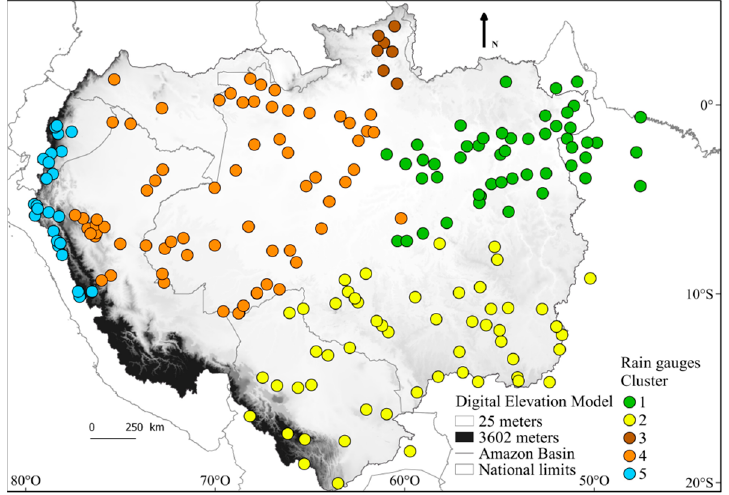
Figure 2. Rain gauge network used as ground reference (205 stations with daily data from 1998 to 2013). The colors of the stations and the labels allow identifying the climatic regions with similar rainfall regimes